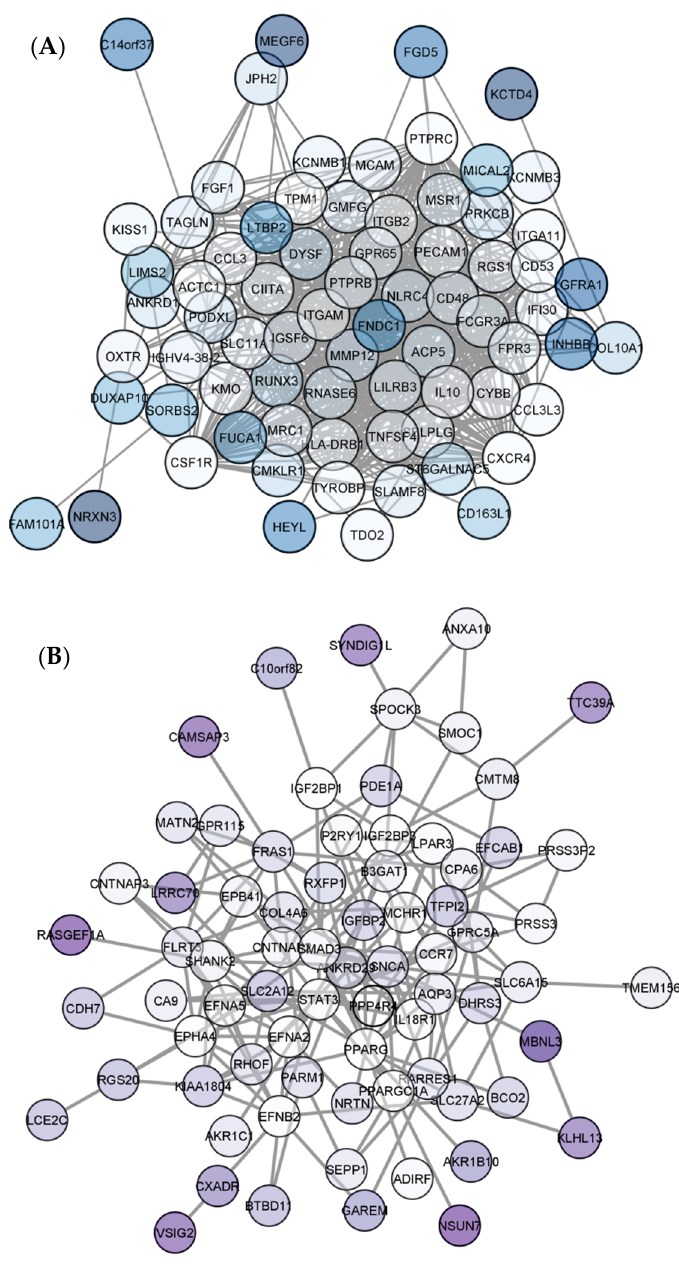
Figure 5. Visualization of the protein–protein interaction network of CC. In figure ( A ), the PPI network for up-regulated genes with 76 nodes and 656 edges and in figure ( B ) the PPI network for down-regulated genes with 76 nodes and 151 edges.